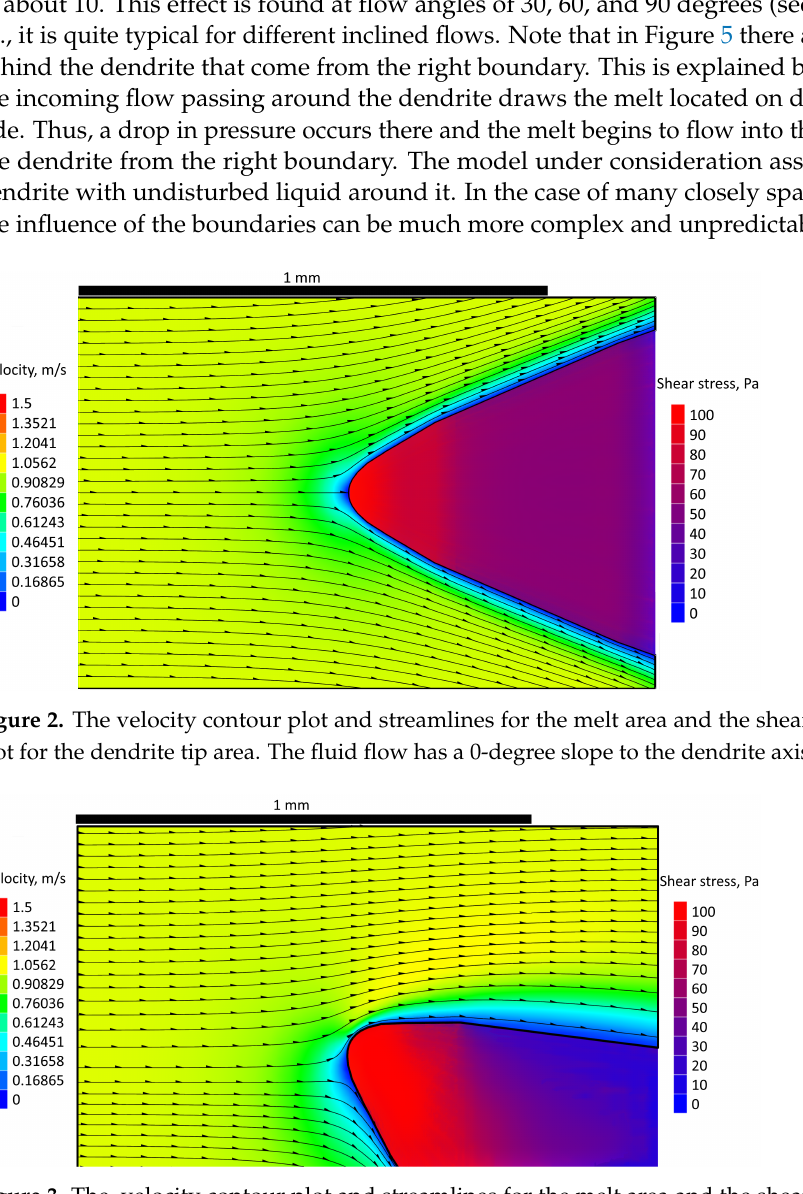
Figure 3. The velocity contour plot and streamlines for the melt area and the shear stress contour plot for the dendrite tip area. The fluid flow has a 30-degree slope to the dendrite